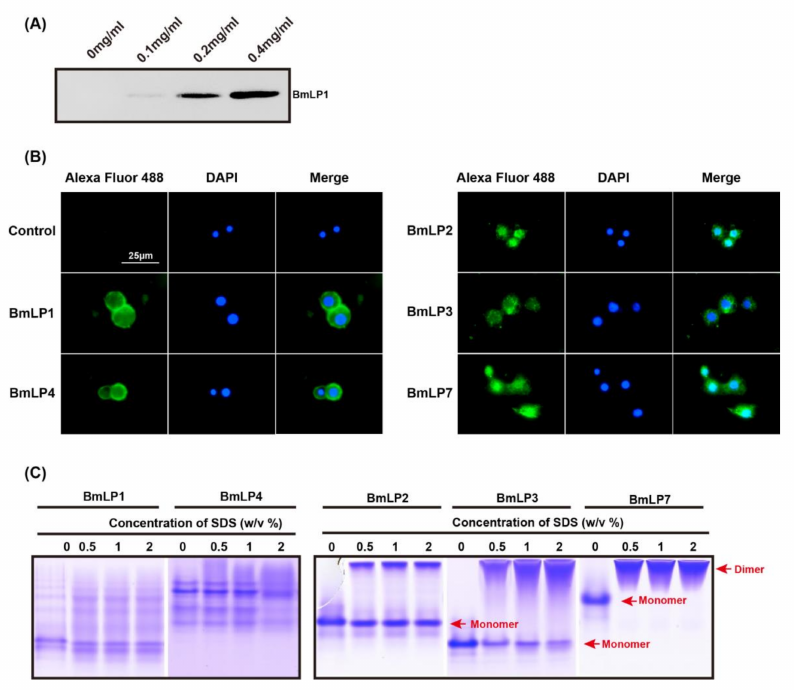
Figure 5. Binding of BmLP1 to hemocytes of the fifth instar larvae revealed using western blotting ( A ). Different concentrations of purified proteins in Grace’s medium were incubated with hemocytes for 2 h at room temperature, washed four times with PBS, and hemocyte proteins were extracted using RIPA Lysis Buffer. BmLP1 was detected using mouse anti 6 × his-tag antibodies and HRP- conjugated goat anti mouse antibodies. The sample with no protein was used as the control. The binding and location of BmLP1, BmLP2, BmLP3, BmLP4 and BmLP7 in hemocytes were revealed by immunofluorescence ( B ). Purified proteins in Grace’s medium were incubated with hemocytes for 2 h at room temperature and washed four times with PBS. The proteins were detected using mouse anti 6 × his-tag antibodies and Alexa Fluor 488-labeled Goat anti mouse antibodies. The sample with no protein was used as the control. The dimerization of BmLP1, BmLP2, BmLP3, BmLP4 and BmLP7 were performed by non-reduce PAGE ( C ). The recombinant BmLP1 and BmLP3 were incubated with different concentrations of SDS for 20 min. The final concentrations of SDS were 0.5%, 1% and 2%. The dimers were isolated using non-reduce PAGE and stained using Coomassie Brilliant Blue